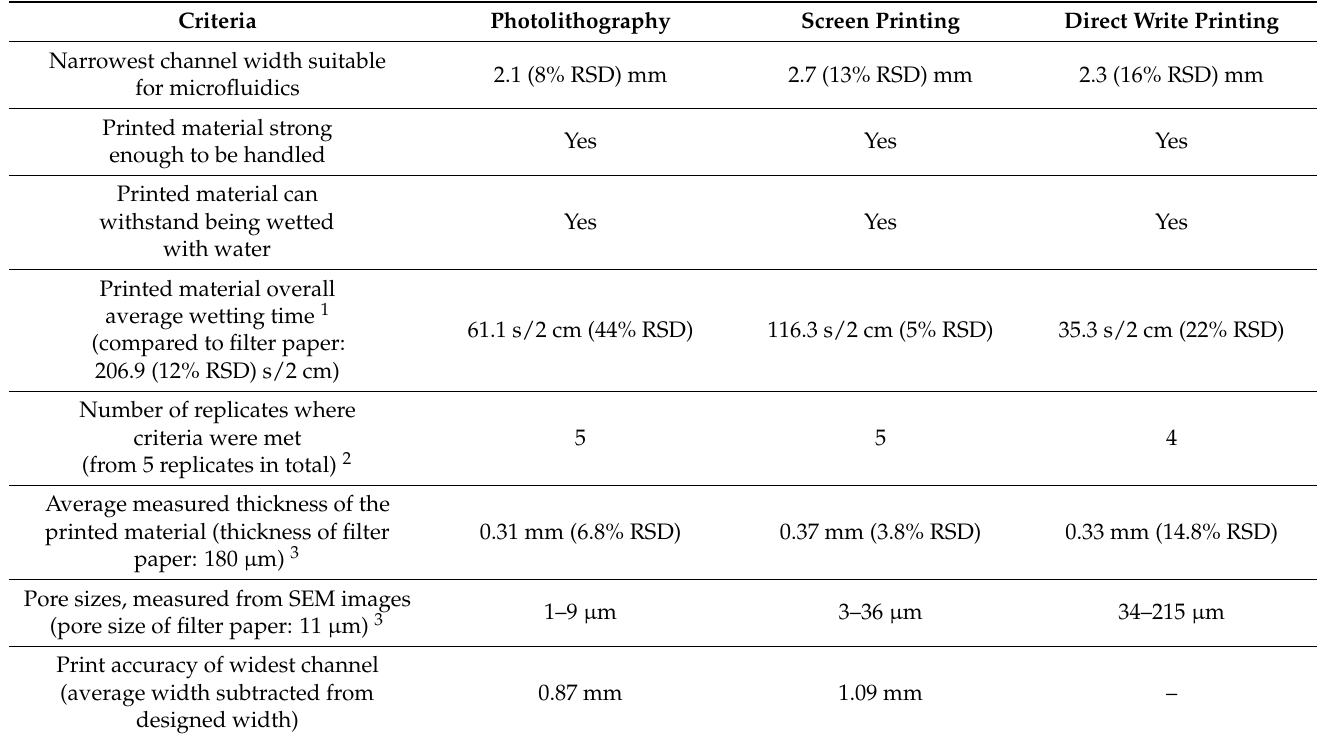
Table 1. Comparison of the different printing methods to (1) the criteria set in this article to the microfluidic system and (2) each